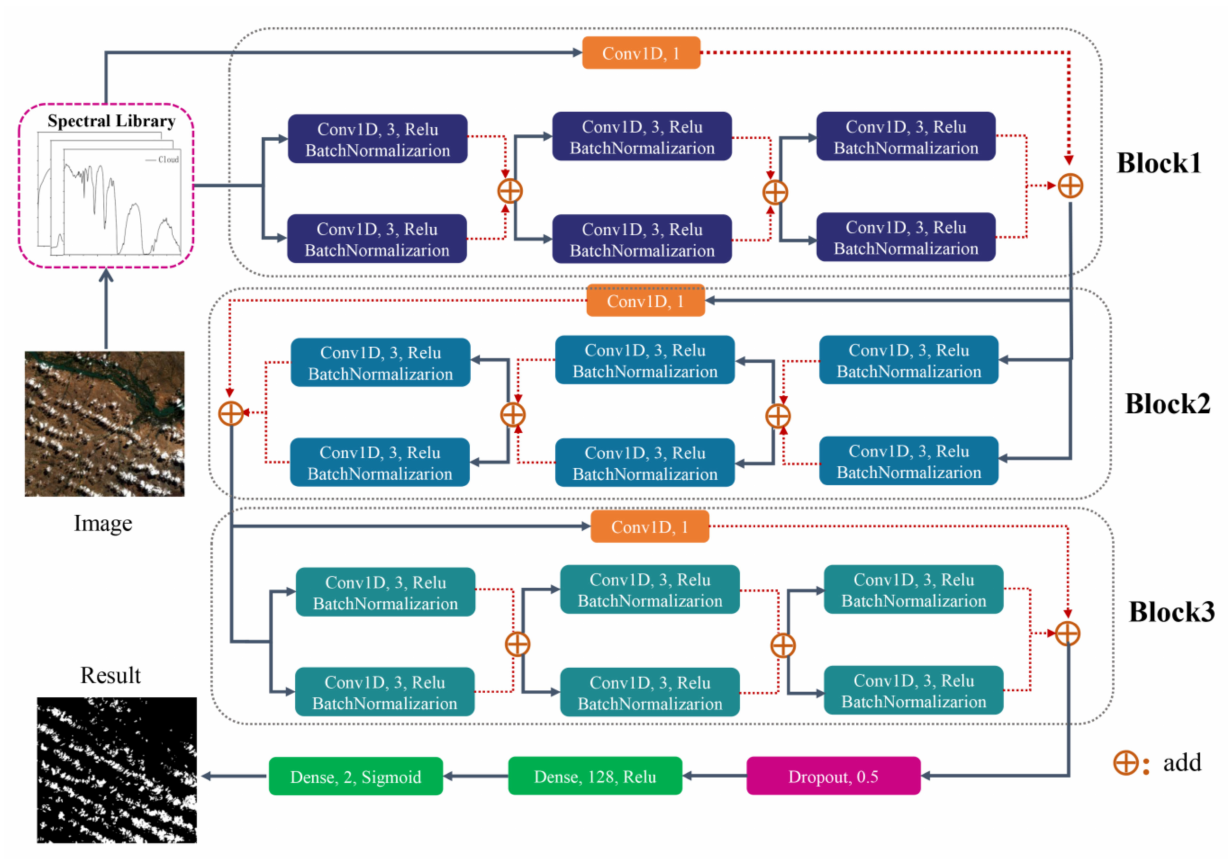
Figure 5. Network structure of cloud detection algorithm. Block1, Block2, and Block3 represent three identical residual modules. Each block contains residual learning (Conv 1D, 1) and a dual-channel convolutional